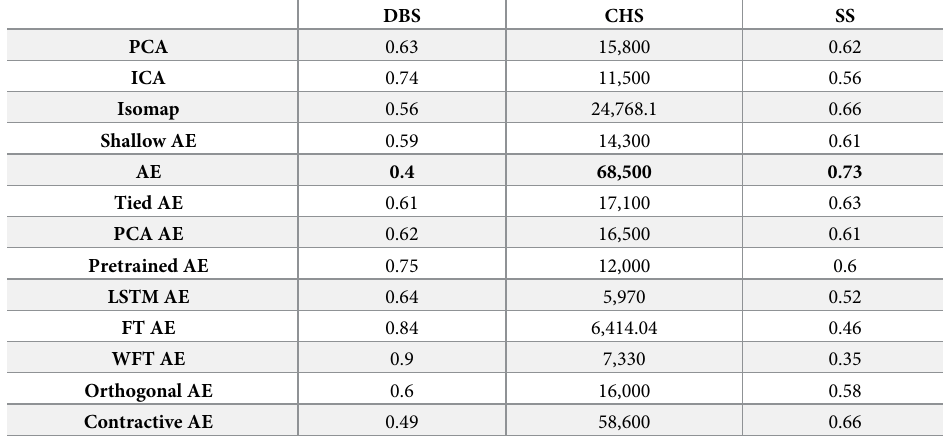
Table 11. Comparison of different autoencoder variations vs state-of-the-art methods on real data channel 6, the optimal value of neighbours for Isomap was found as 30 through grid search. The metrics indicate that for this dataset the AE variant is able to outperform the conventional feature extraction algorithm with regard to all metrics while the other variants have similar performances to that of PCA and ICA. The values indicating the highest perfor- mance for each metric have been